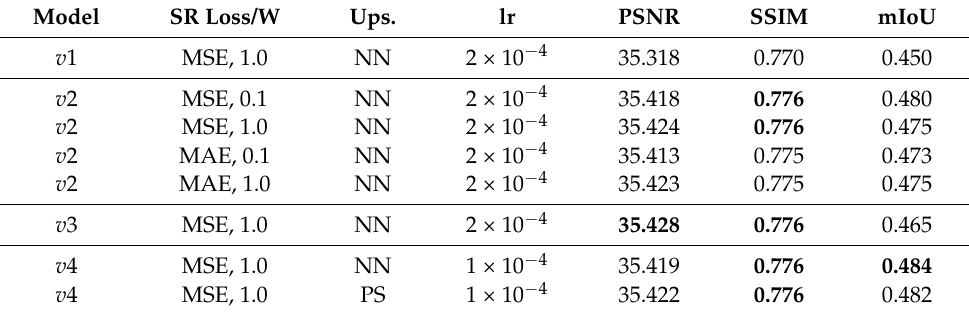
Table 3. Results obtained on the test set using the four variants of the dual network model ( v 1 to v 4). Only the best performing configurations are shown. Upsampling techniques are NN (Nearest Neighbors) and PS (Pixel-Shuffle), lr is the learning rate, the semantic segmentation loss is weighted CE in all cases. Best values in bold. Model SR Loss/W Ups. lr PSNR SSIM MSE, 1.0